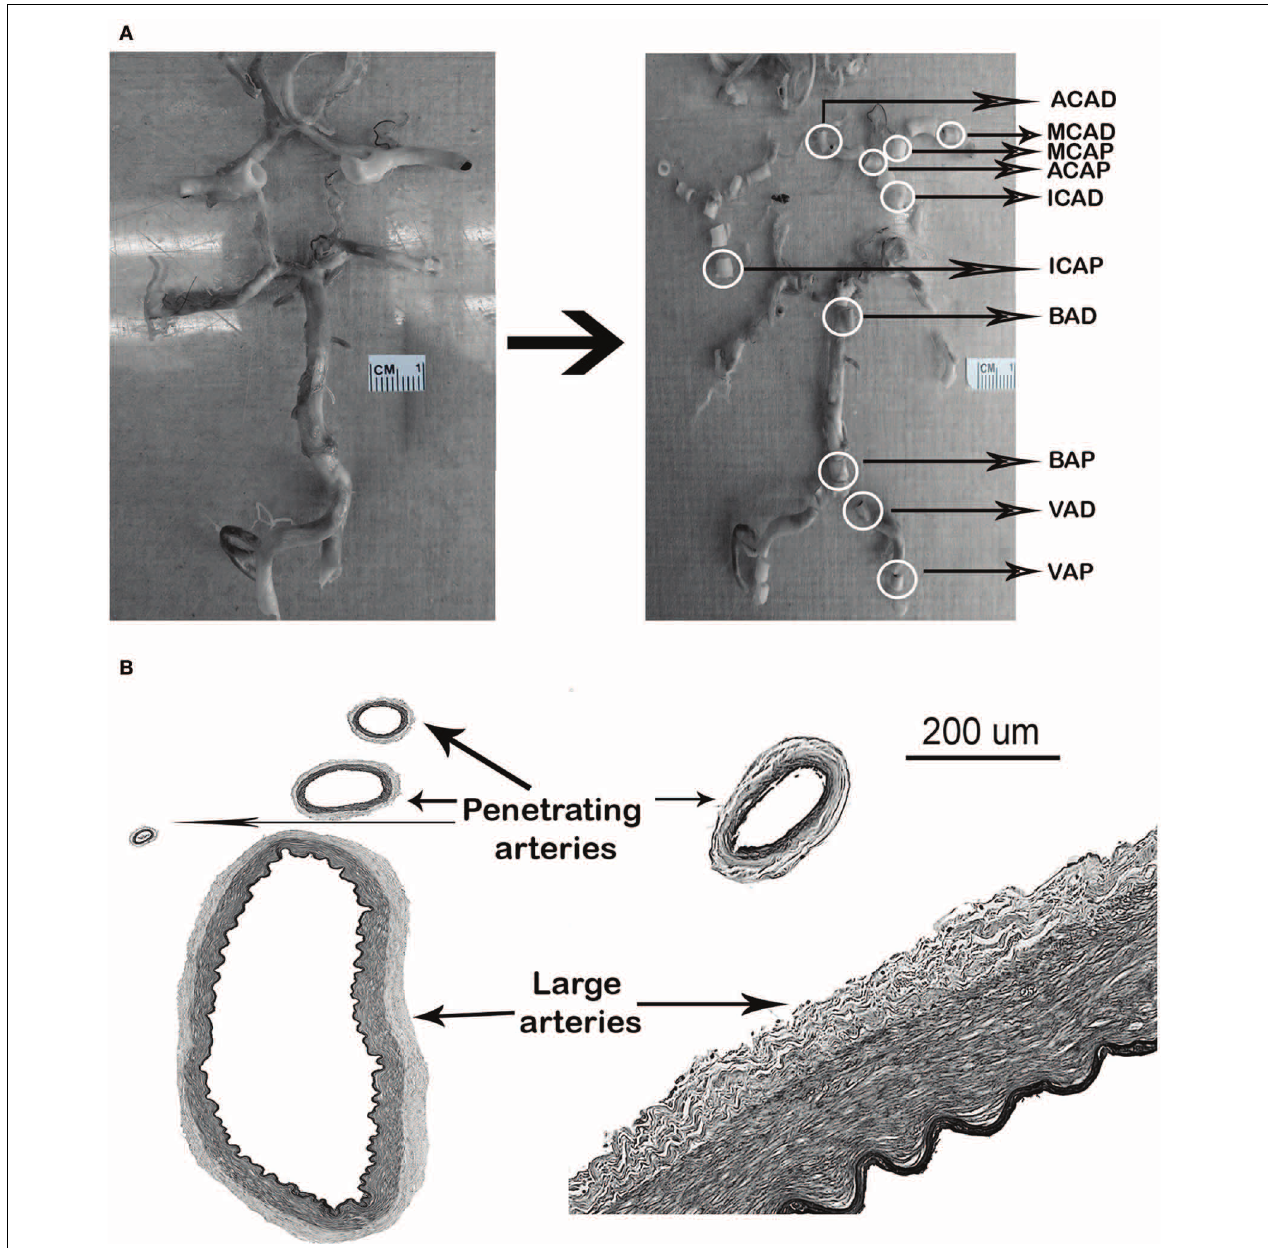
FIGURE 1 | Examples of arterial identification. (A) Circle of Willis, identification, and section of arterial segments. (B) Identification of penetrating arteries neighboring the parent large artery. D, distal; P, proximal.